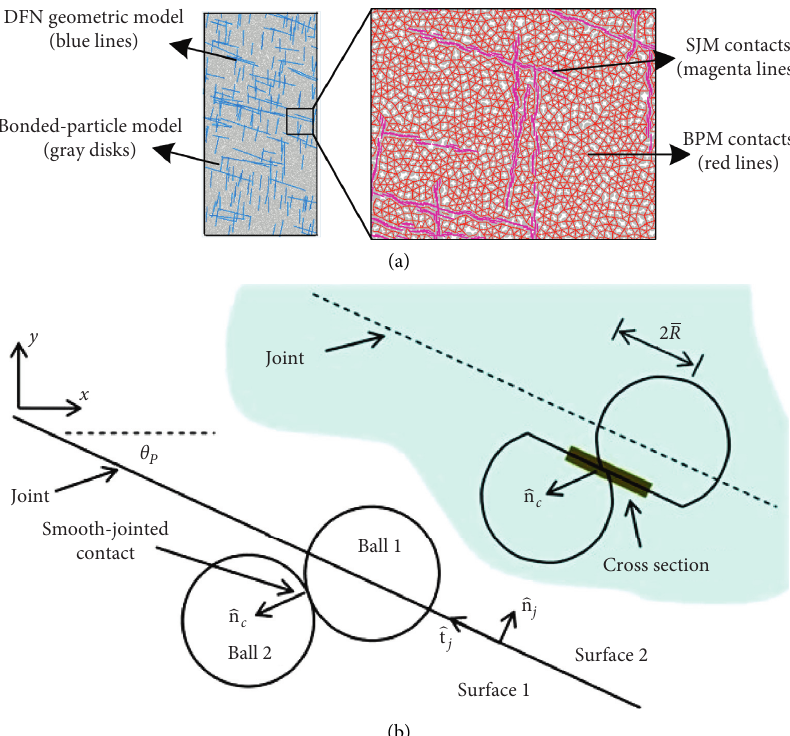
Figure 3: Synthetic rockmass specimen and the smooth-jointed model logic. (a) Overview of an SRM specimen. (b) Contact behavior of the smooth-jointed model (from Mas Ivars et al.